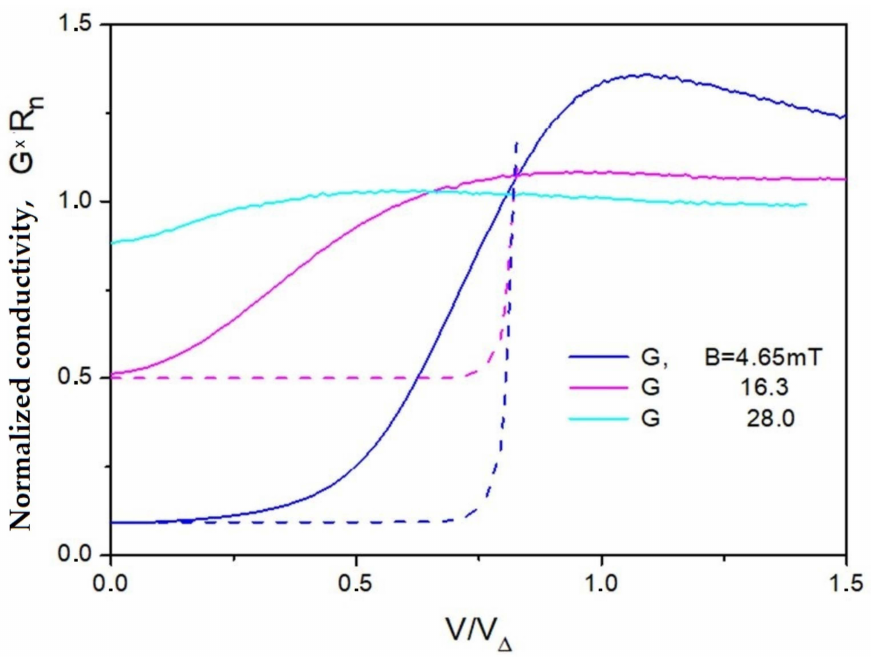
Figure 6. Normalized conductivity G × R n dependence in linear scale on normalized voltage V/V ∆ for magnetic field of 4.65, 16.3, and 28 mT. Dashed lines are simulated for shunting of perfect NIS junction by 0.5/R n and 0.1/R n